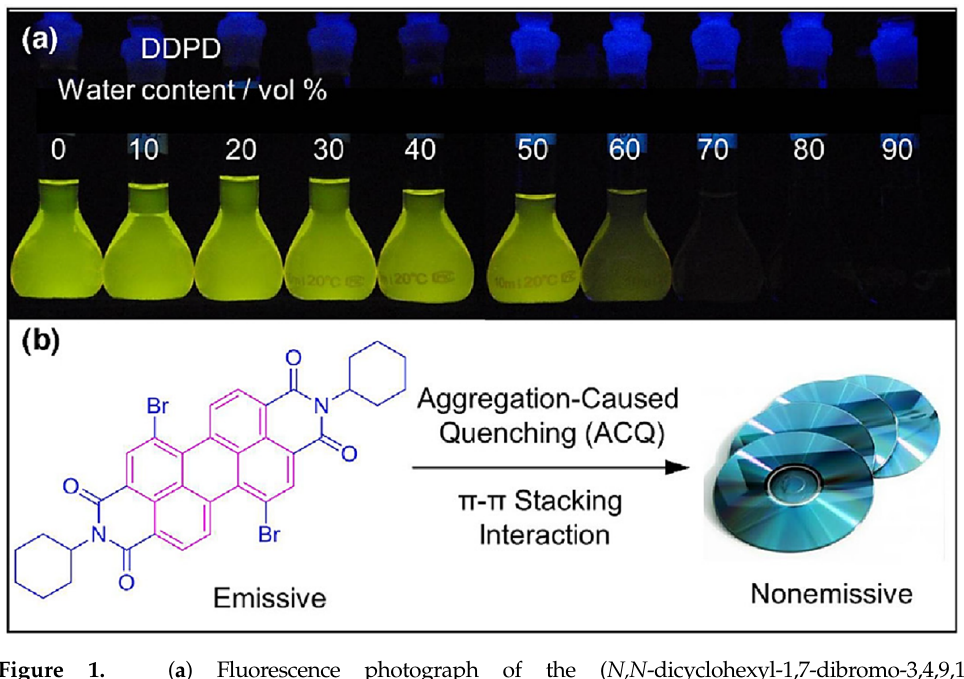
Figure 1. ( a ) Fluorescence photograph of the ( N,N -dicyclohexyl-1,7-dibromo-3,4,9,10-perylenetetracarboxylic diimide) molecule with increasing water content and ( b ) showing the aggregation-caused quenching (ACQ) phenomenon. Reprinted from reference [13] with the permission of the Royal Chemical Society.